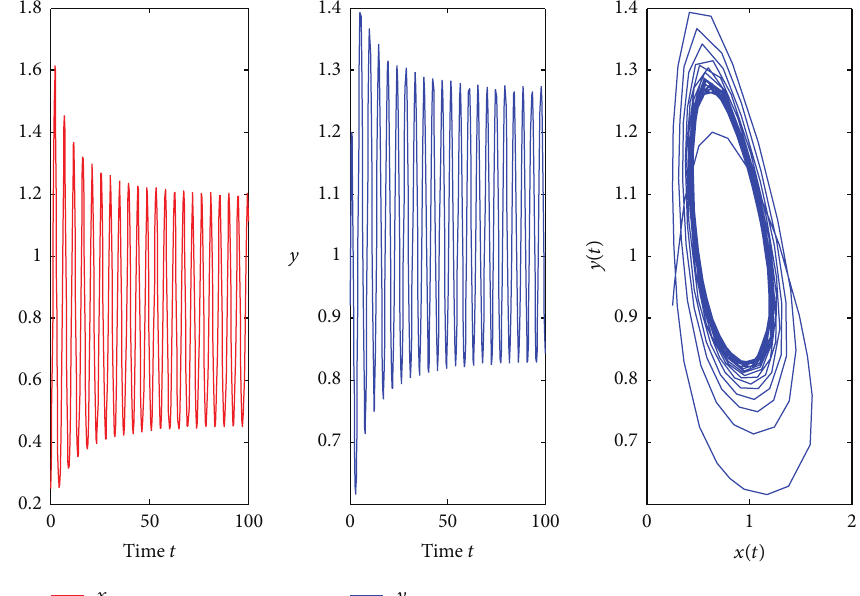
Figure 2: 𝐸 ∗ is unstable for 𝜏 1 = 1.10 > 𝜏 10 = 1.0241 with initial values “0.25;0.92.”